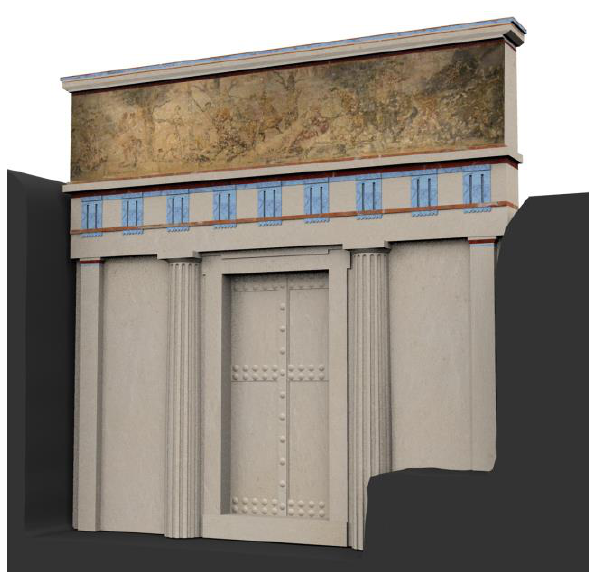
Figure 26. The Tomb of Philip II in Verghina. View from the east. Detail of the 3D